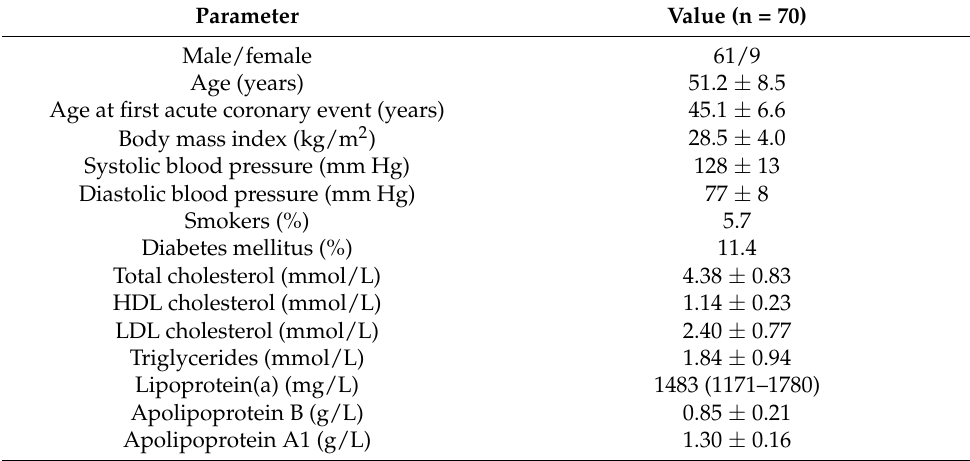
Table 1. Patient